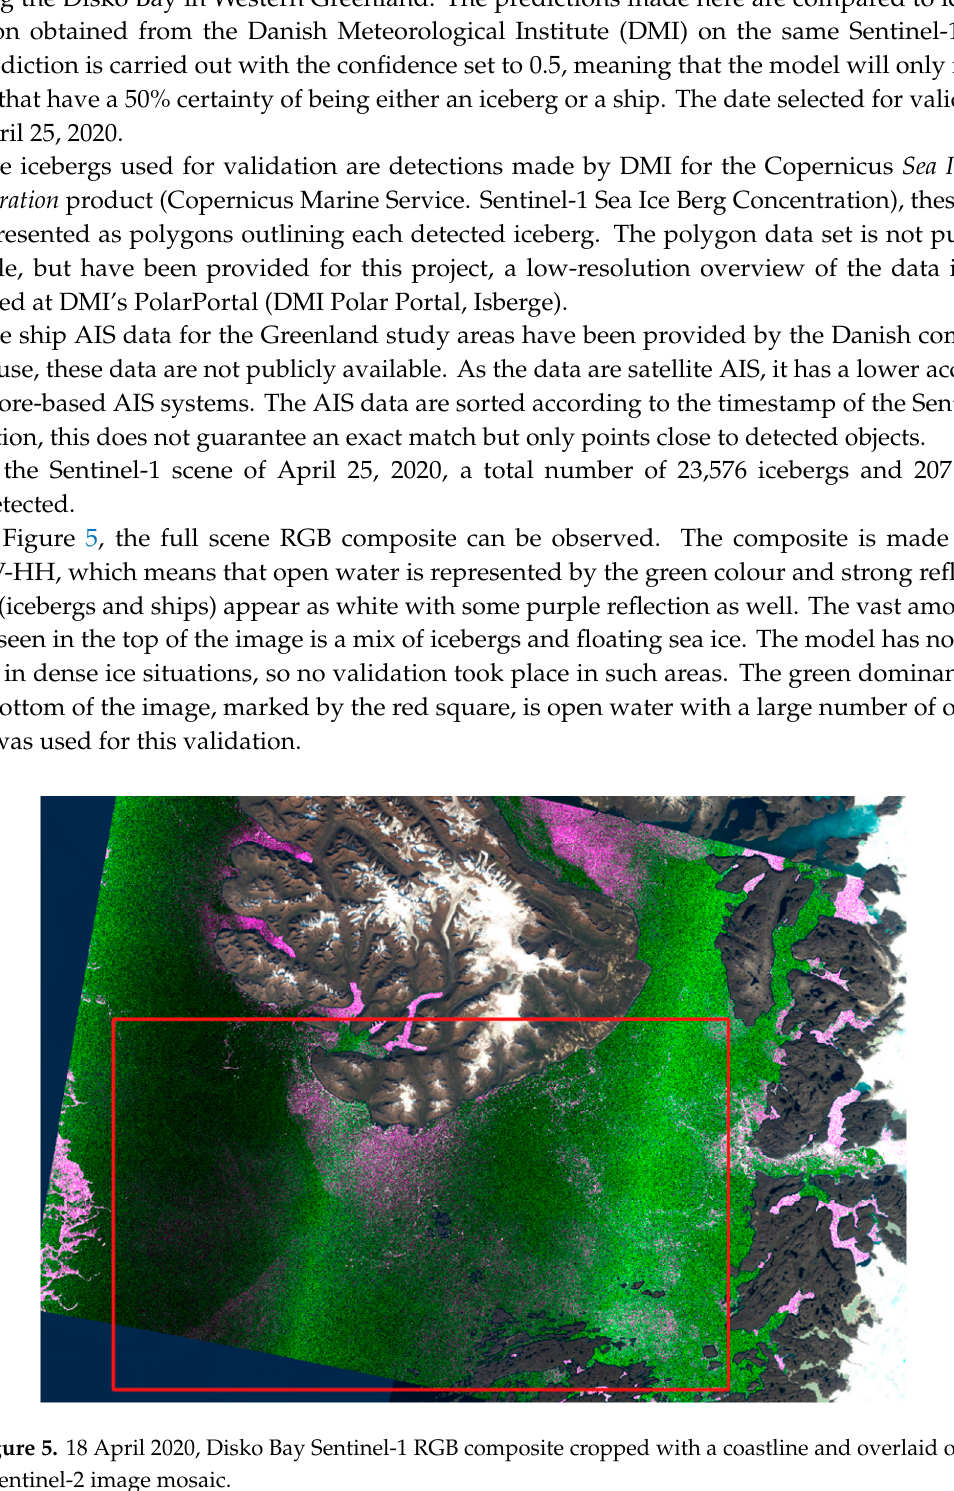
Figure 6. 20 April 2020. Validation area detection output, orange polygons and red dots are validation objects. Blue marks are iceberg detections, and red marks are ship detection (too few to see in the figure). In the validation area, DMI detected a total of 4601 icebergs, these are the orange polygons in Figure 6. The polygons appear to have a small offset towards the left, this is due to differences in Sentinel-1 pre-processing. With the use of DMI iceberg polygons, the detections made by the study are validated against these. The polygons are used as ground truth and the model is validated by measuring how many of these were detected. In the areas without iceberg ground truth, validation is not possible. Each iceberg polygon is validated with three possible outcomes: “detected as iceberg”, “detected as ship”, or “not detected”. A validation overview is shown in Table 3. The validation shows that out of the 2340 icebergs detected by DMI, 54.95% of them were detected by the model. A fraction of these were correctly detected but classified wrongly as ships.